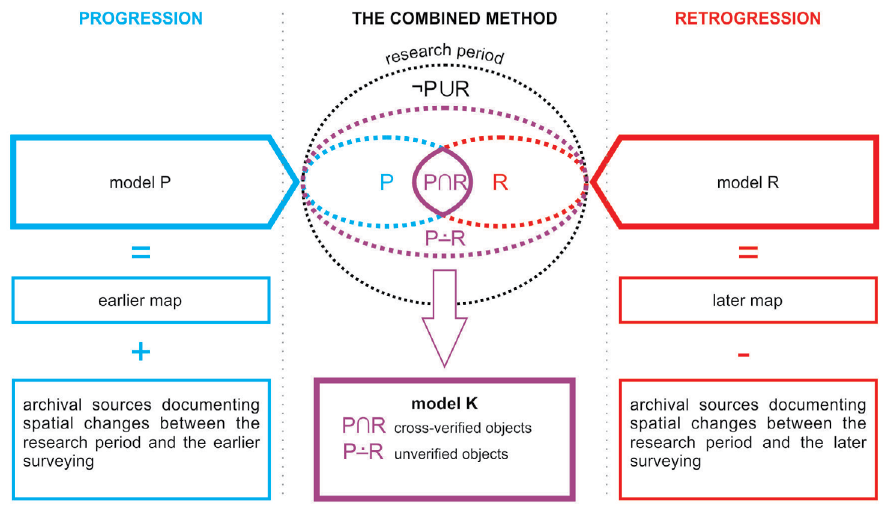
Fig. 1. The scheme of cartographic reconstruction with the combined method. The ‘K’ model consists of joined models ‘R’ and ‘P’ (the sum ‘R P’). The common part of ‘R’ and ‘P’ models (‘R P’) is mutual for both retrogression and progression, therefore it is the area of increased reliability of the reconstruction (positive ∪ ∩ cross-validation). The ‘K’ model does not fill the whole reality, there is a part that is impossible to be reconstructed with retrogression or progression (denied sum of ‘R P’) (J. Kuna ∪